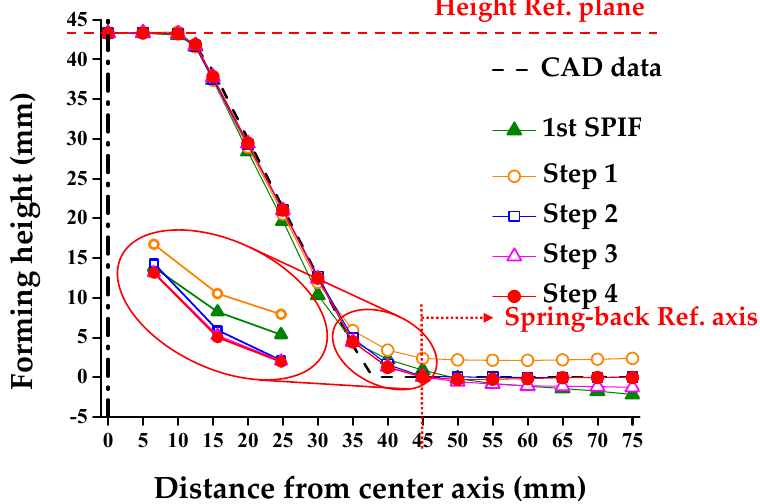
Figure 15. Variation of cross-sectional shape according to the compensation step. Table 5. Comparison of the circular cup shape according to each compensation step.